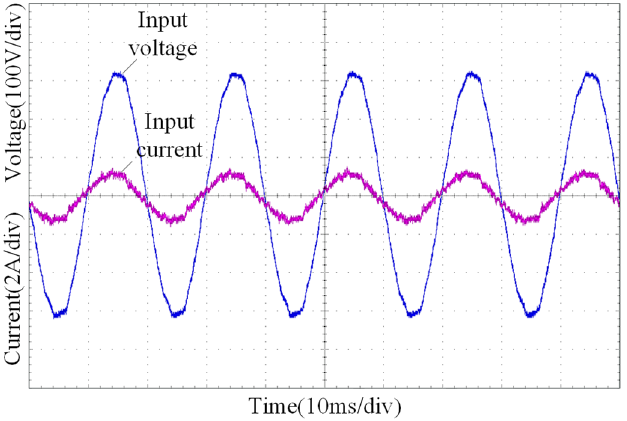
Figure 18. Input voltage and current waveform of bridgeless PFC with power decoupling circuit.